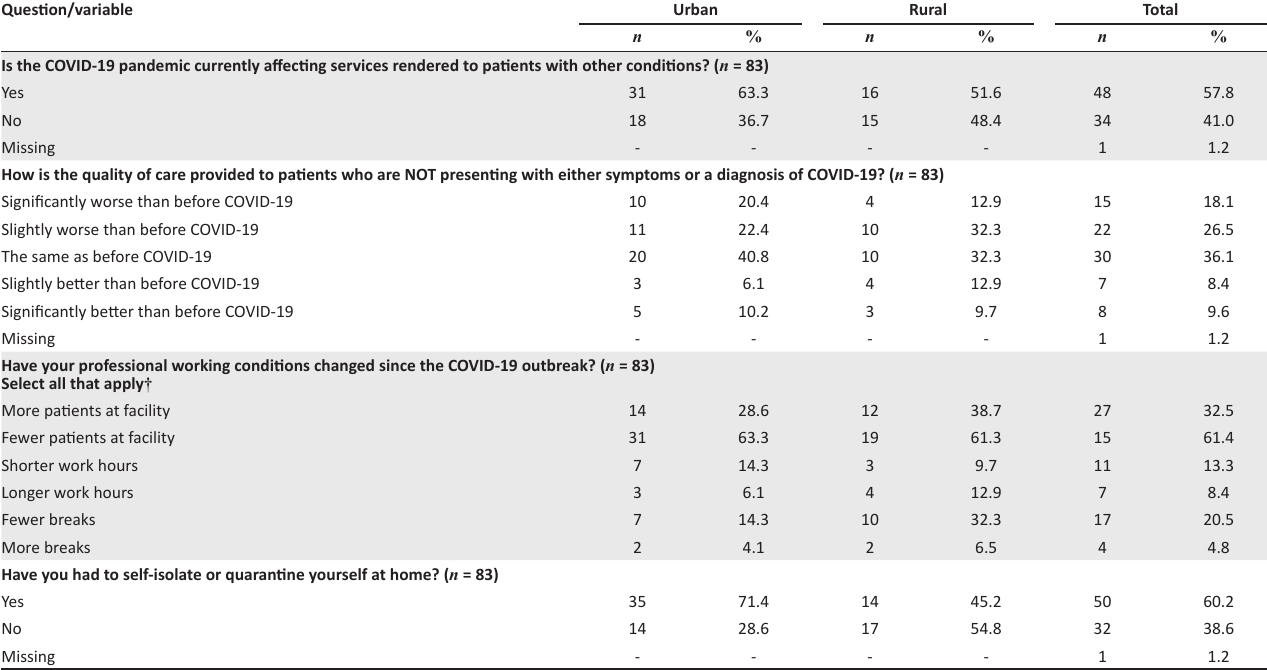
TABLE 6: Services quality.